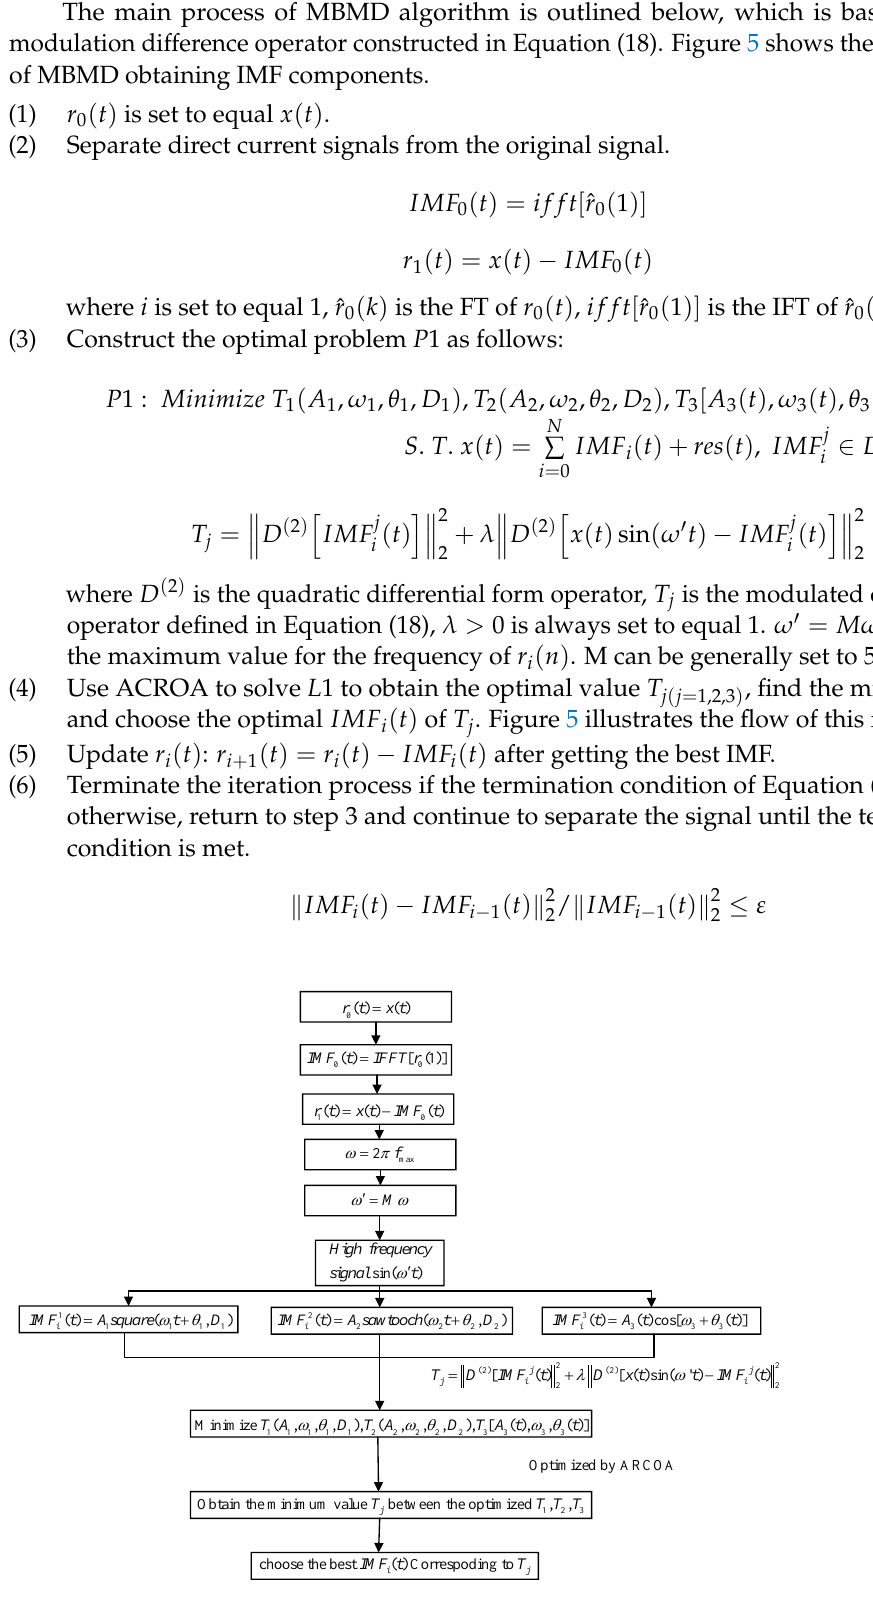
Figure 5. Flow chart of MBMD to obtain IMF.